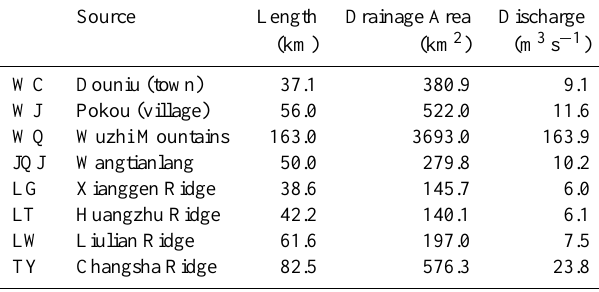
Table 1. Length, drainage area and annual average freshwater dis- charge of rivers of the eastern Hainan Island. Wenchanghe (WC) and Wenjiaohe (WJ), in the city of Wenchang; Wanquanhe (WQ), Jiuqujiang (JQJ) and Longgunhe (LG), in the city of Qionghai; Longtouhe (LT), Longweihe (LW) and Taiyanghe (TY), in the city of Wanning (Wang, 2002; Zhang et al., 2006).